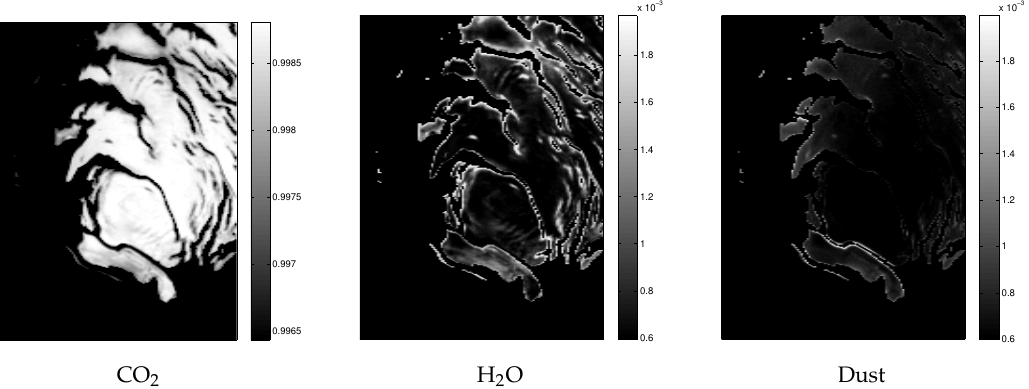
Figure 6. The abundances of the three endmembers computed by GRSIR [58], based on a physical model of the SPPC reflectivity.